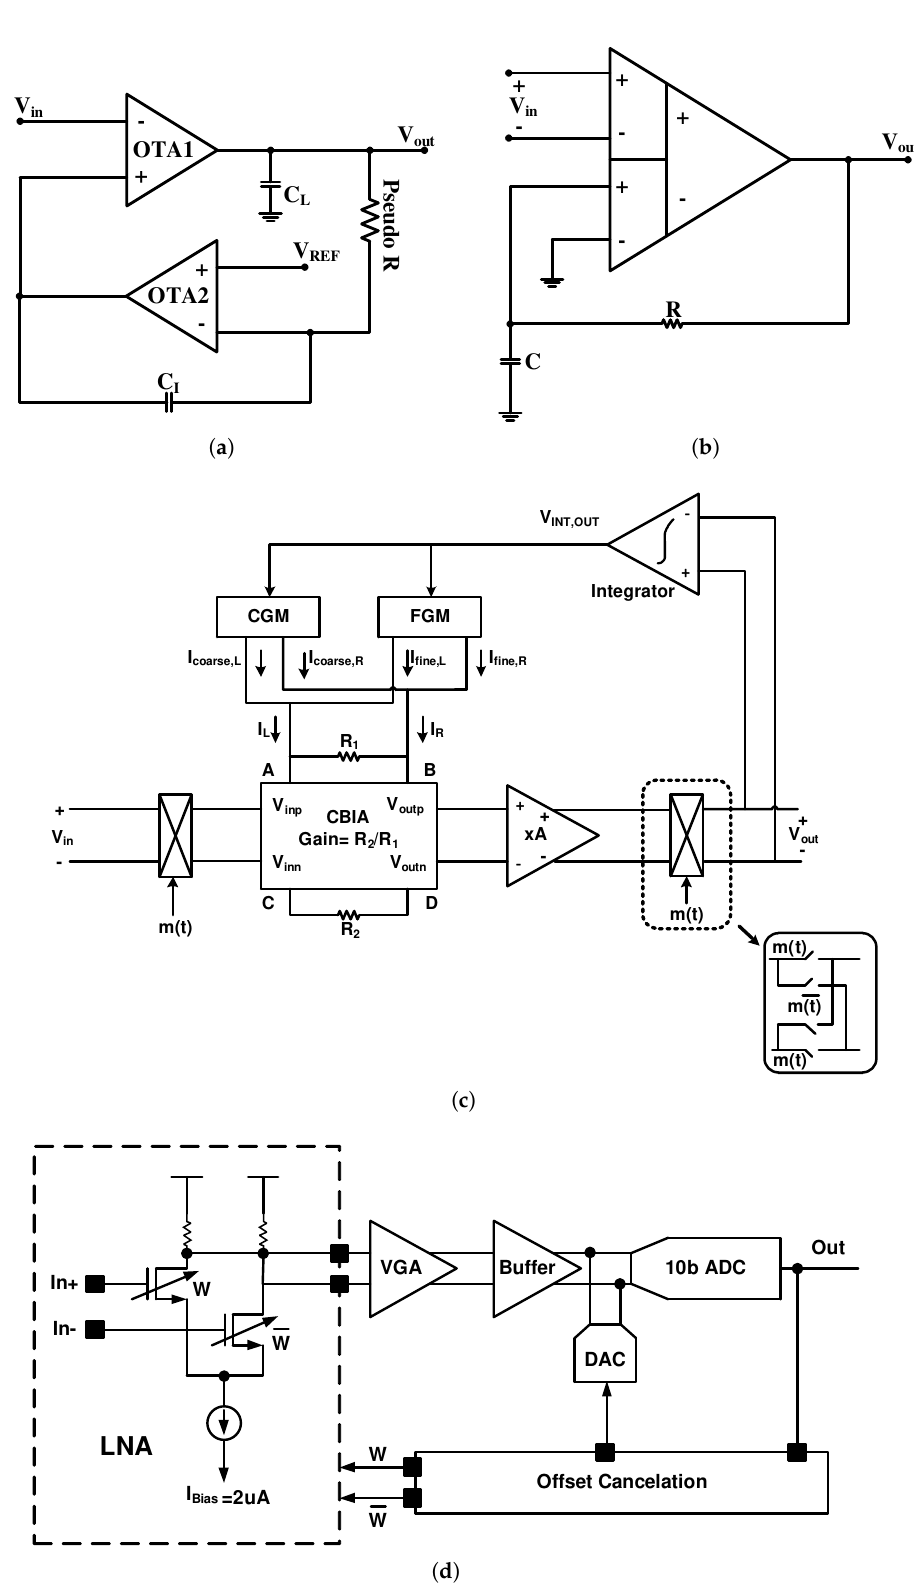
Figure 4. DC-coupled neural amplifiers utilizing ( a ) an analog active low-pass filter (LPF); ( b ) an analog passive LPF and a differential difference amplifier; ( c ) analog and digital DC servo loops (DSL); and ( d ) input differential pair width modulation by an offset cancellation